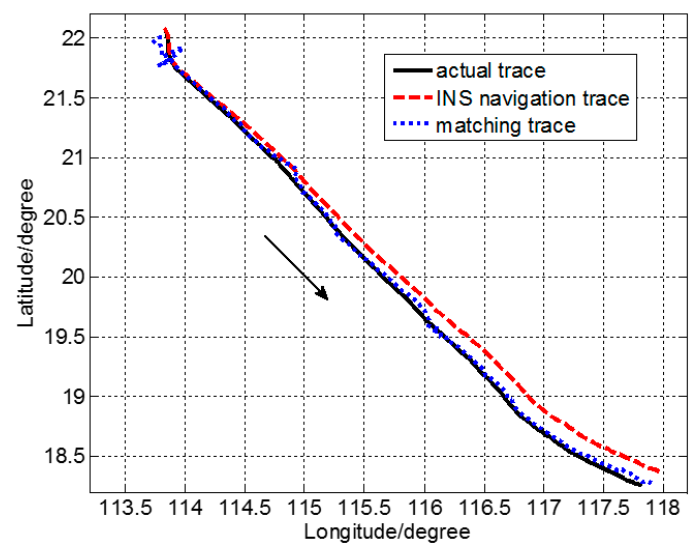
Figure 6. Matching location trace in the simulation under noise condition u = 1 mGal and σ 2 = 9 mGal 2 .